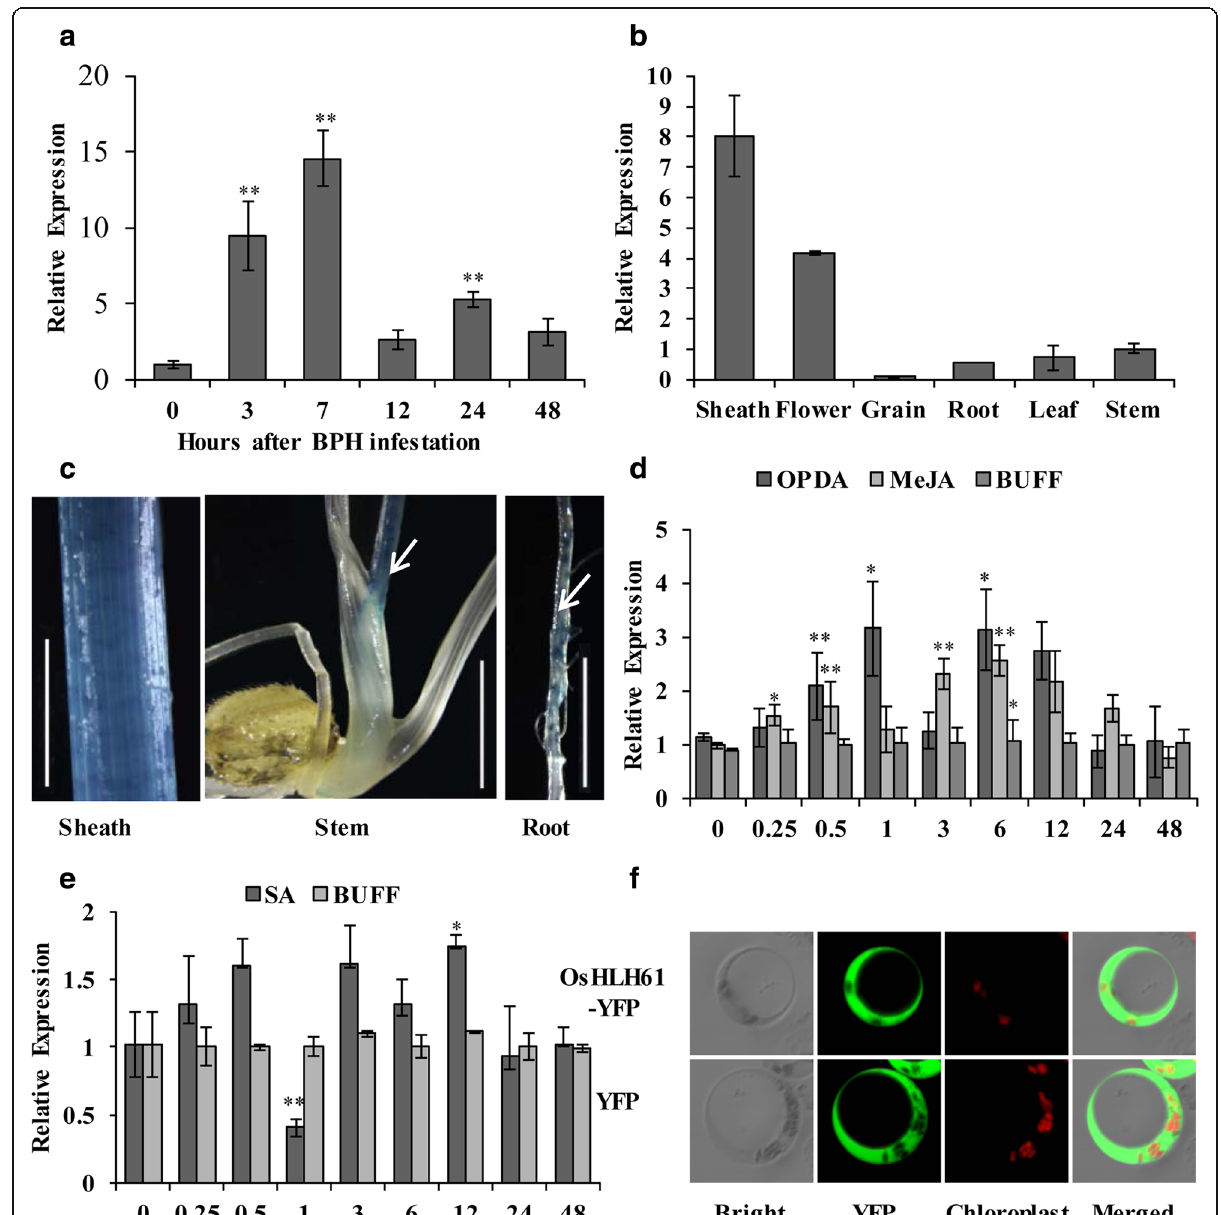
Fig. 2 Expression profile of OsHLH61 and subcellular localization of OsHLH61 protein. a Expression levels of OsHLH61 transcripts after BPH infestation ( n = 10). b Expression levels of OsHLH61 transcripts in different tissues ( n = 3). c Histochemical staining of the tissues in OsHLH61p::GUS transgenic plants, scale bar = 1 cm. d Expression levels of OsHLH61 transcripts after OPDA and MeJA treatments ( n = 3). e Expression levels of OsHLH61 transcripts after SA treatment ( n = 3). f Transient localization of OsHLH61-YFP in rice protoplast. Asterisks in ( a ), ( d ) and ( e ) represent significant differences determined by Student ’ s t -test at * P < 0.05 and ** P <